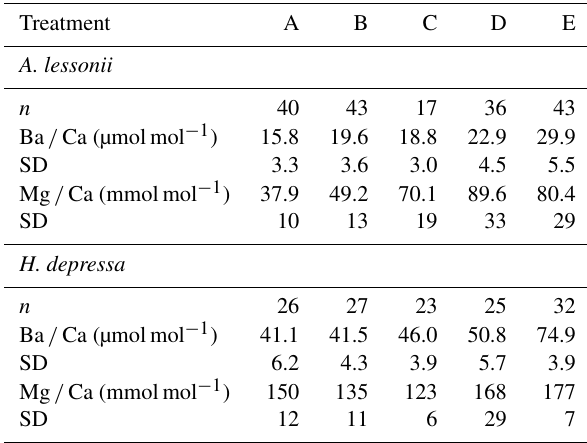
Table 2. Measured Ba / Ca and Mg / Ca for A. lessonii and H. de- pressa for each